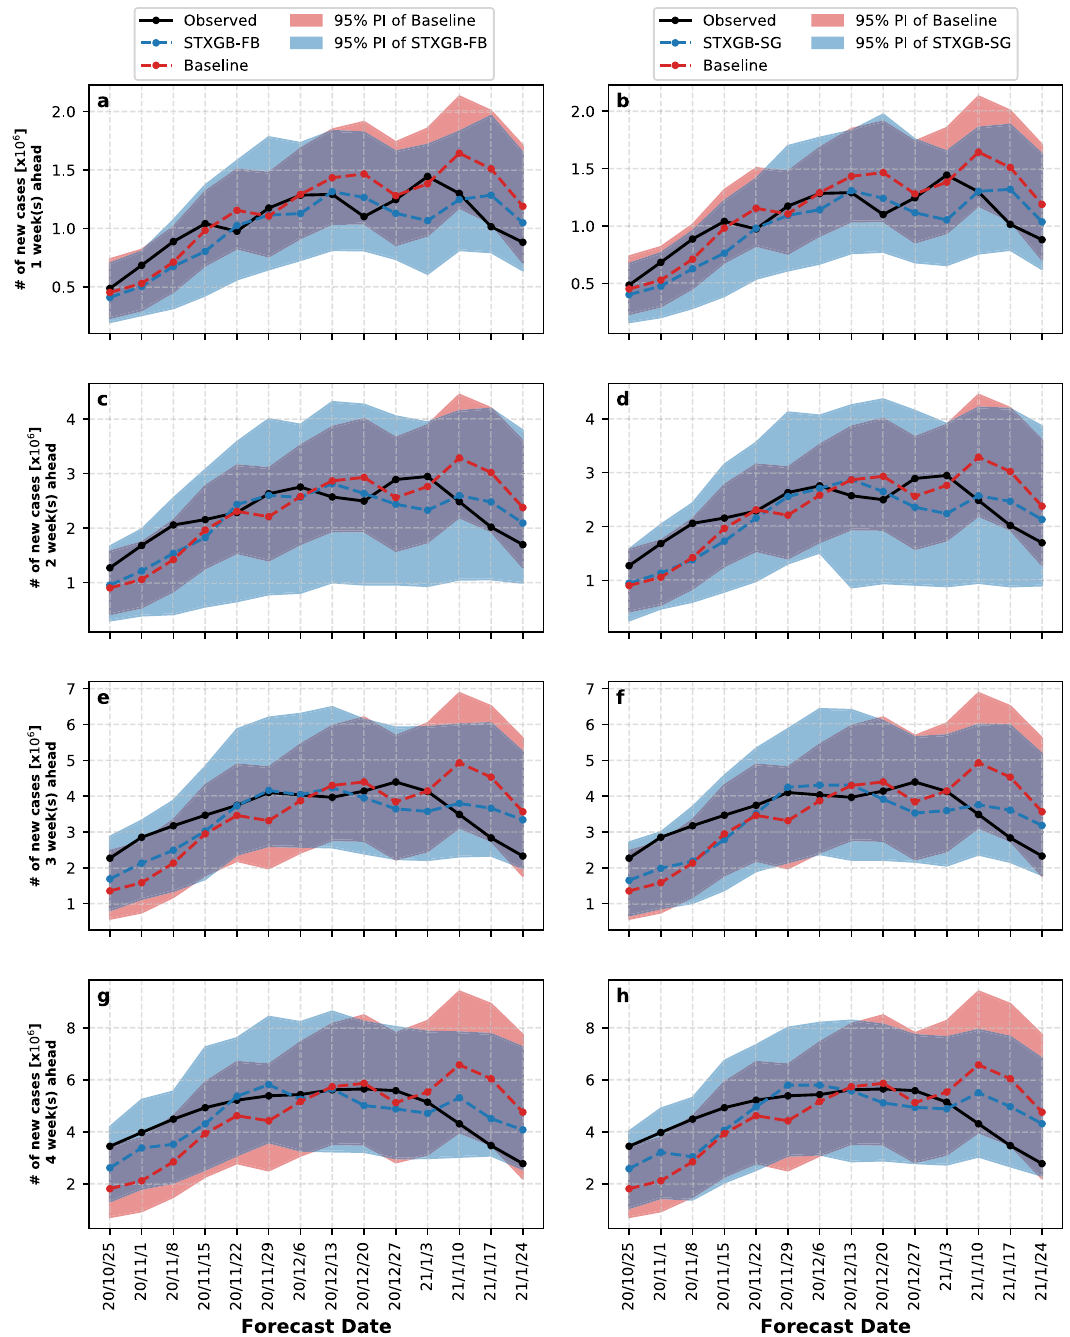
Fig. 3 About 95% prediction interval of the STXGB models compared with the COVIDhub-Baseline over four prediction horizons. The panels on the left show the predictions of the total number of cases and 95% PIs of STXGB-FB (blue dashed lines and regions, respectively) compared with the COVIDhub- Baseline (red dashed lines and regions). The panels on the right show the predictions of the total number of cases and 95% PIs of STXGB-SG compared with the COVIDhub-Baseline using a similar color scheme. The solid black lines represent the total number of observed cases at each forecast date. a and b One-week horizon, c and d two-week horizon, e and f three-week horizon, and g and h four-week